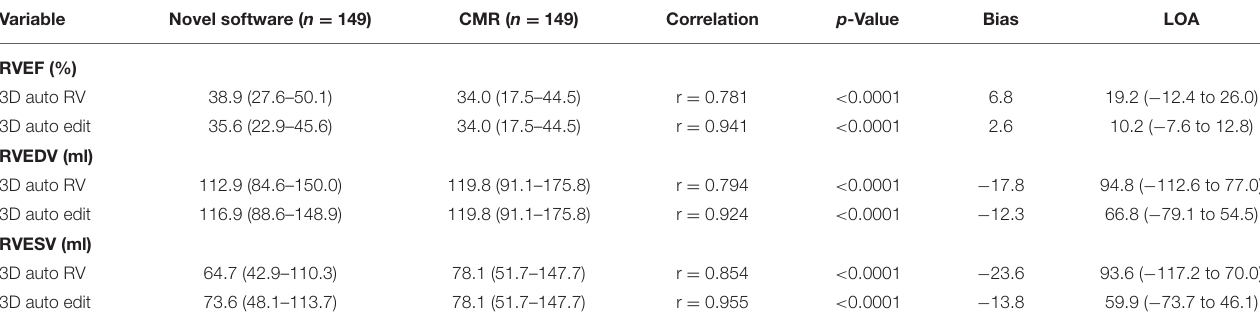
TABLE 2 | Comparison between cardiac magnetic resonance (CMR) and three-dimensional (3D) auto right ventricular (RV) quantification with or without manual editing.